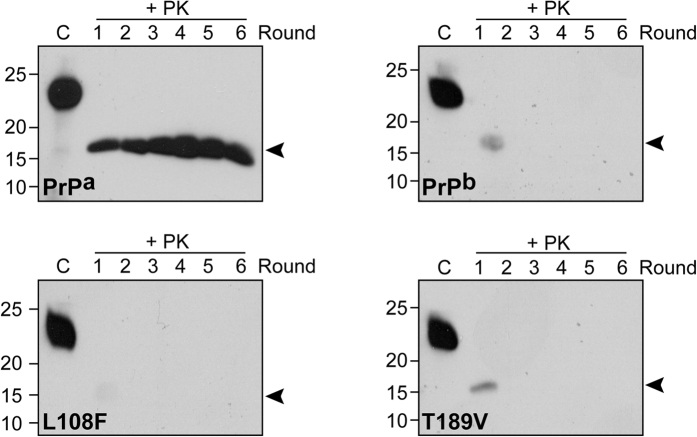
PMCA propagation of recPrion.Recombinant PrPa, PrPb, PrPL108F, or PrPT189V was used as the substrate for PMCA. Each PMCA reaction was carried out for 6 rounds and PMCA products were digested with 50 μg/mL PK at 37 °C for 30 min. PrP was detected by immunoblot analysis with POM1 anti-PrP antibody55. “C” indicates undigested recPrP as a control. The original immunoblot images are in the Supplementary Figure S3.